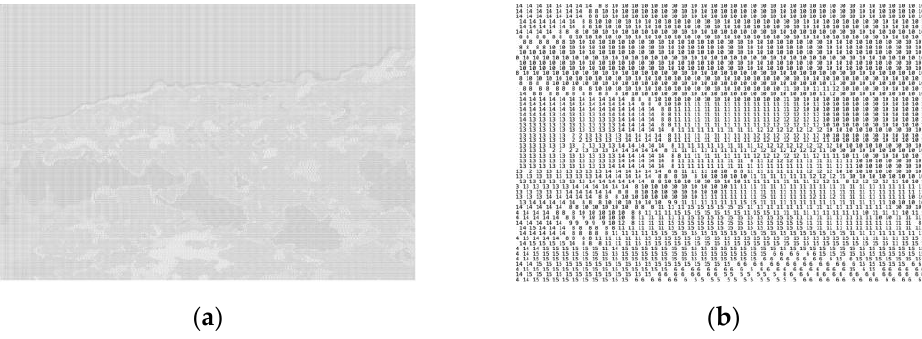
Figure A5. The IDF_ASCII files shown in the text editor. ( a ) It was the full vision; ( b ) It was the local part.